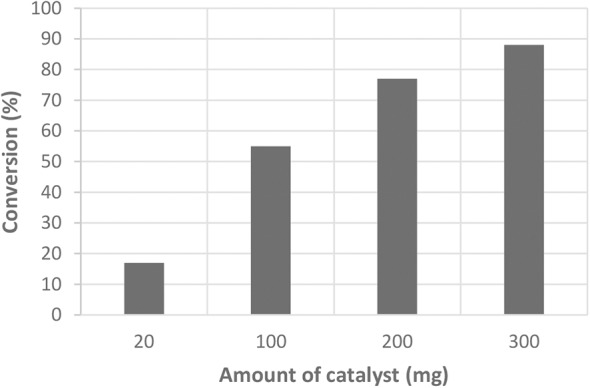
Conversion of cellobiose depending on the amount of catalyst (SO3H/SX+).